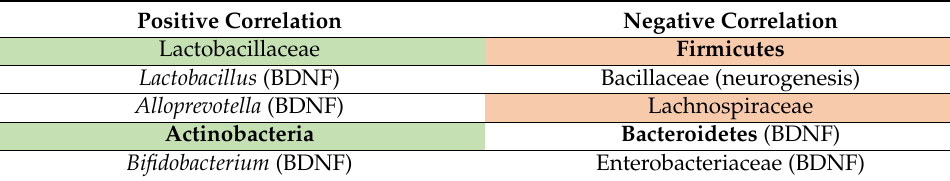
Table 11. Bacterial taxa, with most studies found for positive or negative correlation to neurogenesis and